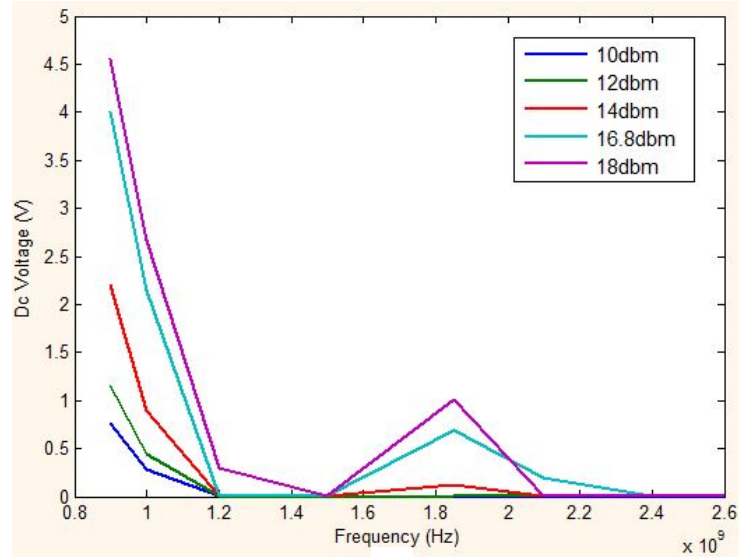
Figure 8. DC voltage at the fifth stage of the self-developed RF-EH board when powering the MSP-EXP430G2 kit. The distance between the TX and RX antennas is 2 cm.